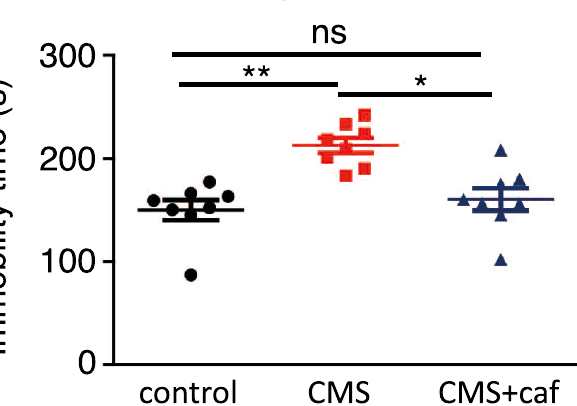
Figure 1. Caffeine protected against CMS-induced depression-like behaviours. Mice were exposed to CMS and were provided with drinking water supplemented with (CMS + caf) or without (CMS) caffeine. Non-CMS- exposed mice were used as controls. During CMS exposure, body weight was monitored weekly ( a ). One week after the last CMS exposure, mice were subjected to the forced swimming test ( b ) and the tail suspension test ( c ). Immobility times were recorded ( b , c ). Eight mice were used in control and CMS group, and nine mice were used in CMS + caf group. Data are shown as mean ± SEM. Similar results were obtained in two independent experiments. * p < 0.05; ** p < 0.01; *** p <